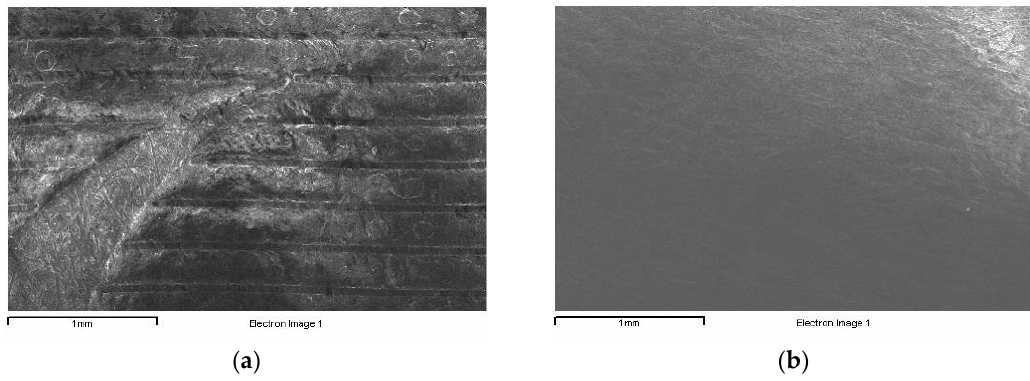
Figure 4. ( a ) SEM image of the flag portion of the genuine banknote. ( b ) SEM image of the flag portion of counterfeit banknote.